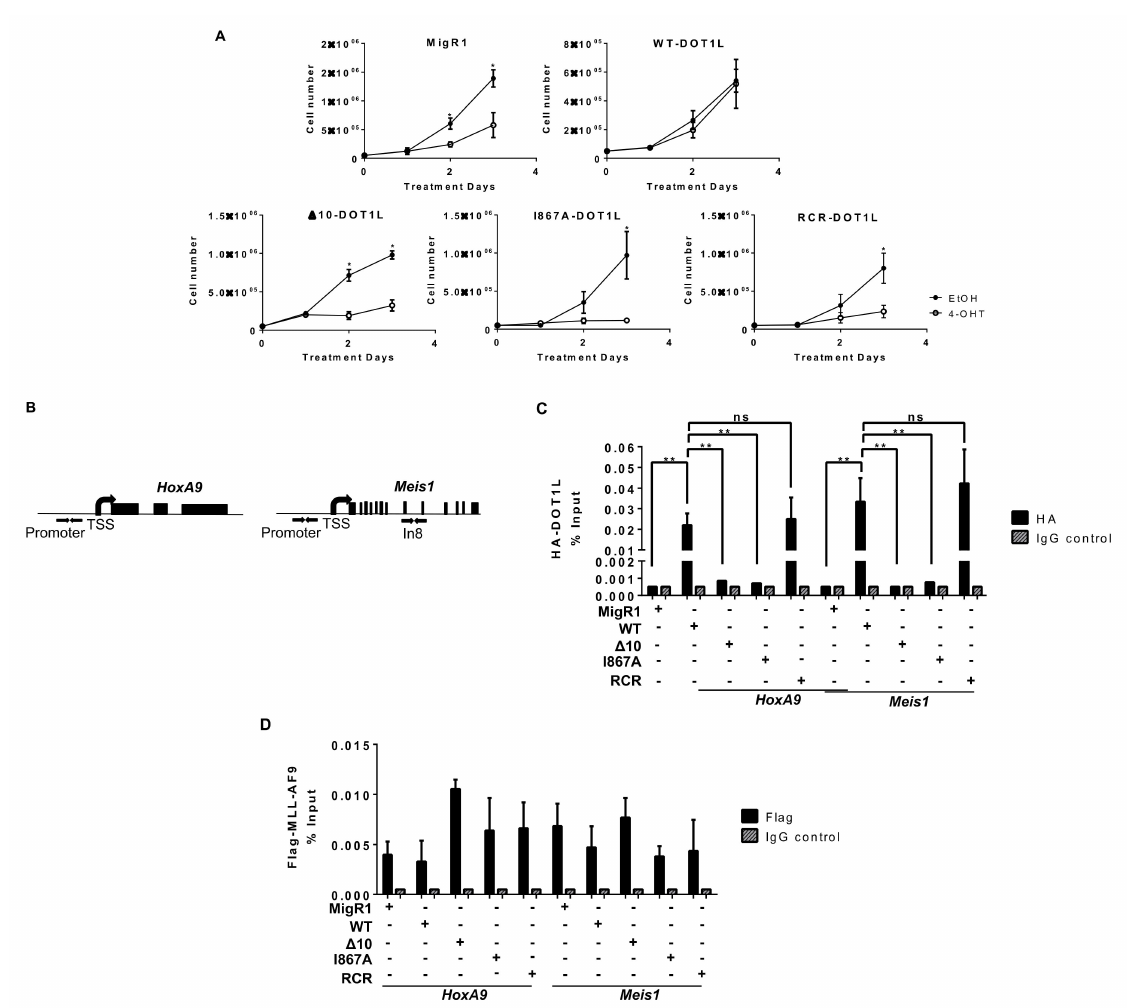
Figure 2. MLL-AF9 mediated proliferation is dependent on the interaction and recruitment of DOT1L. ( A ) Cells were treated at day 0 and day 2 with 7.5 nM tamoxifen (4-OHT) and monitored for cell proliferation. Mutating the AF9-DOT1L interaction site ( ∆ 10 and I867A) significantly reduces cellular proliferation at a similar level to deletion (MigR1) or enzymatic inhibition (RCR) of DOT1L in MLL-AF9 cells (n ≥ 4). ( B ) Schematic representation of HoxA9 and Meis1 gene loci with arrows indicating the location of Chromatin Immunoprecipitation qPCR (ChIP-qPCR) primers for the promoter region. ( C ) Using an anti-HA antibody, DOT1L constructs were immunoprecipitated, showing disruption of the MLL-AF9 and DOT1L interaction at the HoxA9 and Meis1 promoter. Only WT and RCR constructs with the intact PPI interaction site were detected. There was minimal to no enrichment over background for I867A and ∆ 10 (representative data from two independent experiments with technical triplicates). ( D ) An anti-Flag ChIP-qPCR for MLL-AF9 showed no significant difference in localization to both HoxA9 and Meis1 promoters in each cell line with corresponding % input control (representative data from two independent experiments with technical triplicates). Significance key calculated using a t -test on Prizm 6 software (ns p > 0.05, * p ≤ 0.05, ** p ≤